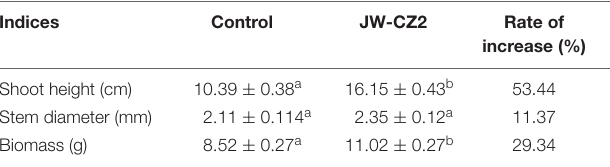
TABLE 1 | Effects of inoculation with S. marcescens JW-CZ2 on growth parameters of tea